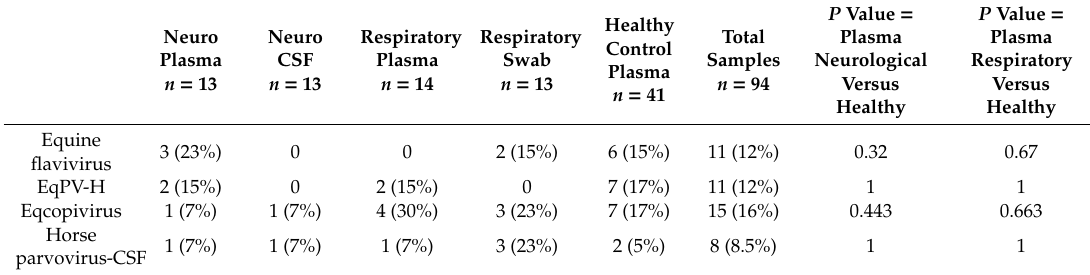
Table 3. Rate of real-time PCR detection for equine viruses and association with unexplained neurological or respiratory diseases using Fisher’s exact